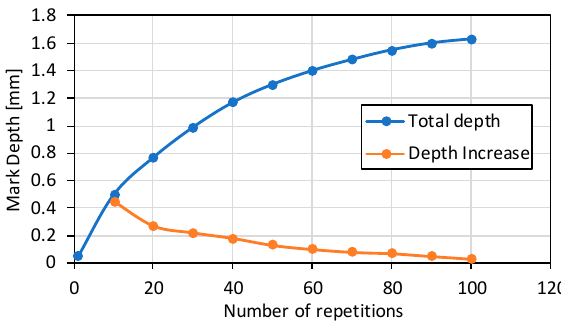
Figure 7. Depth increase as the number of repetitions is increased.